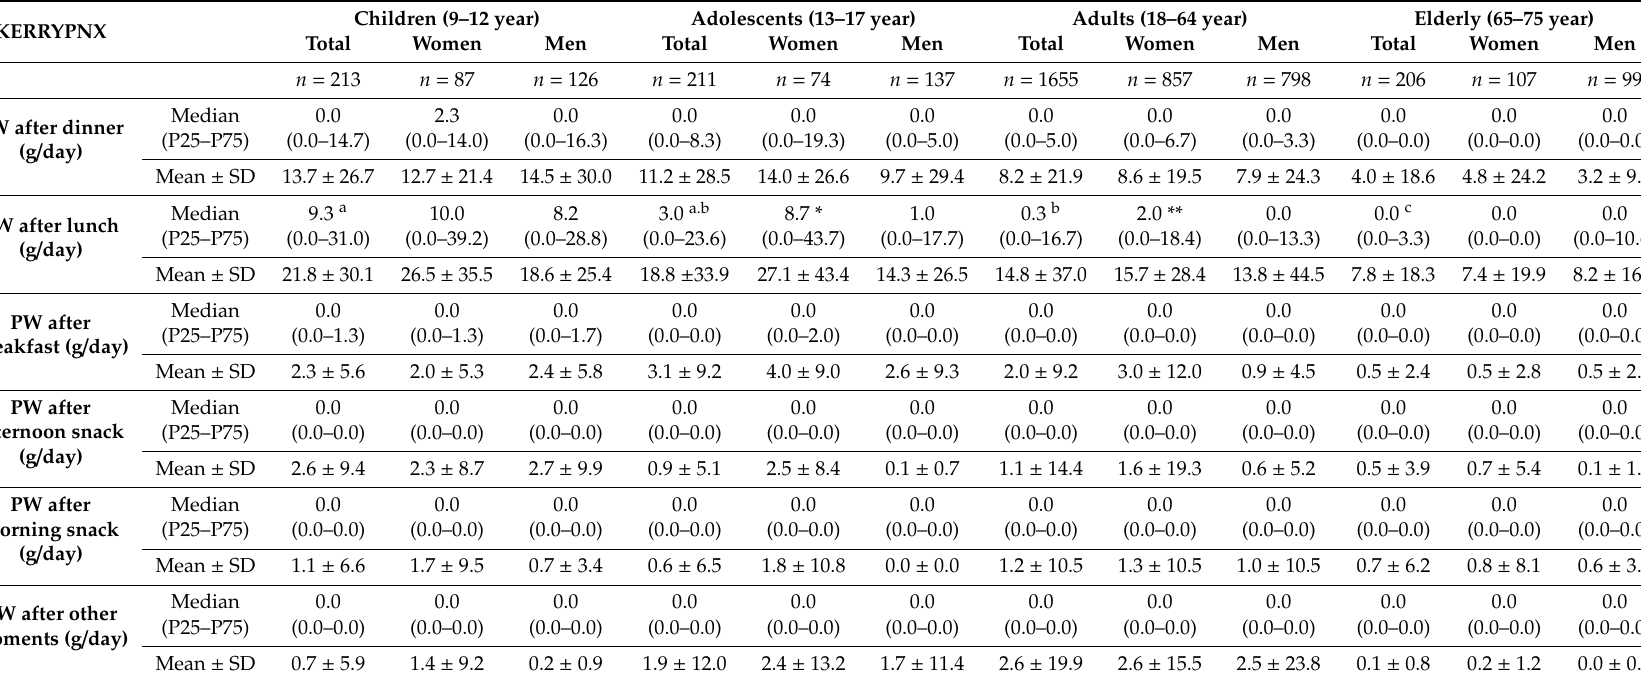
Table 5. Plate waste (PW, g / day)) originated at di ff erent eating occasions by age groups from the ANIBES study